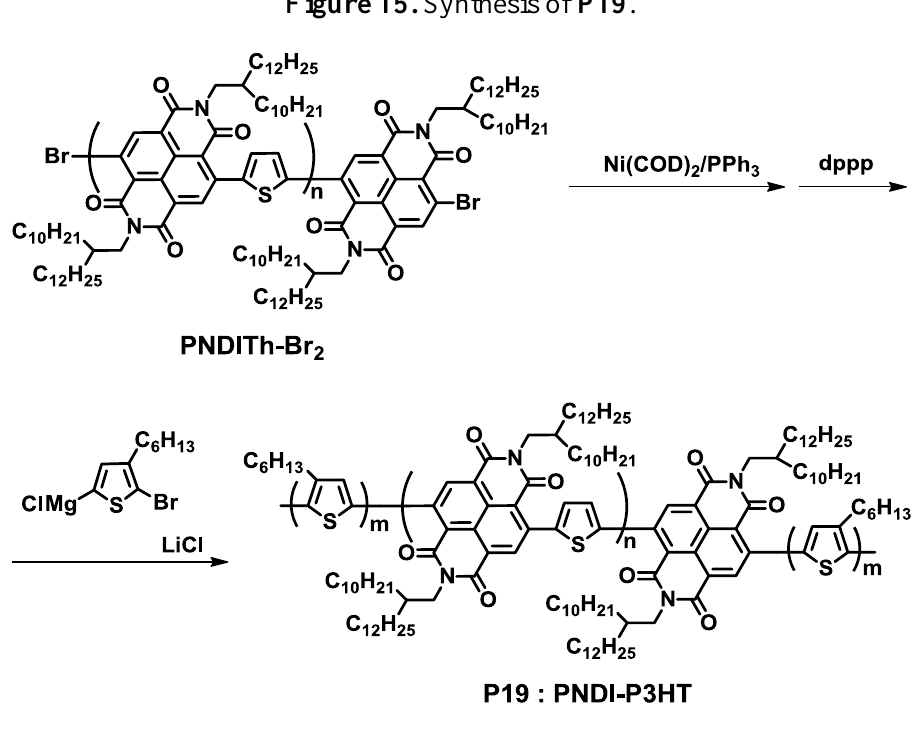
Figure 15. Synthesis of P19